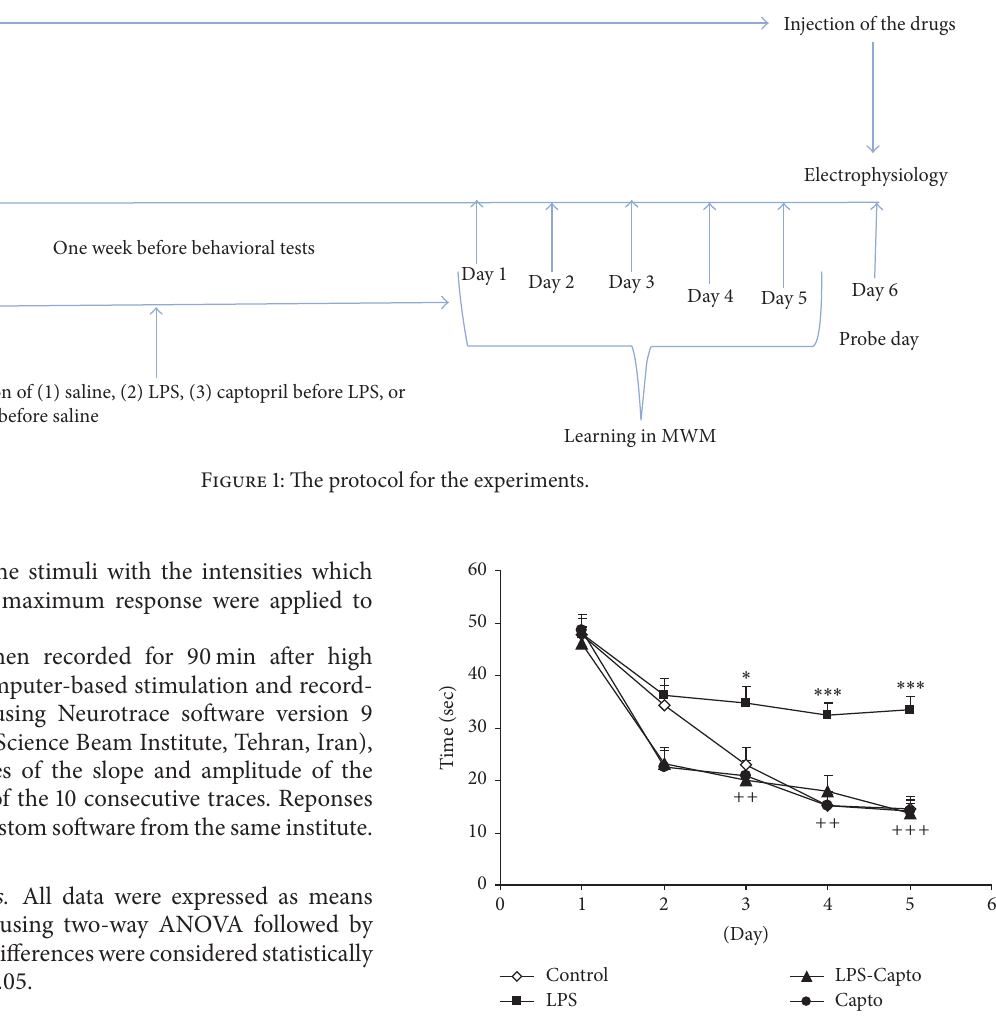
Figure 2: Comparison of time latency to reach the platform in the Morris water maze test between the four groups. Data are presented as mean ± SEM ( 𝑛 = 10 in each group). ∗ 𝑃 < 0.05 and ∗∗∗ 𝑃 < 0.001 compared with the control group and ++ 𝑃 < 0.01 and +++ 𝑃 < 0.001 compared with the LPS